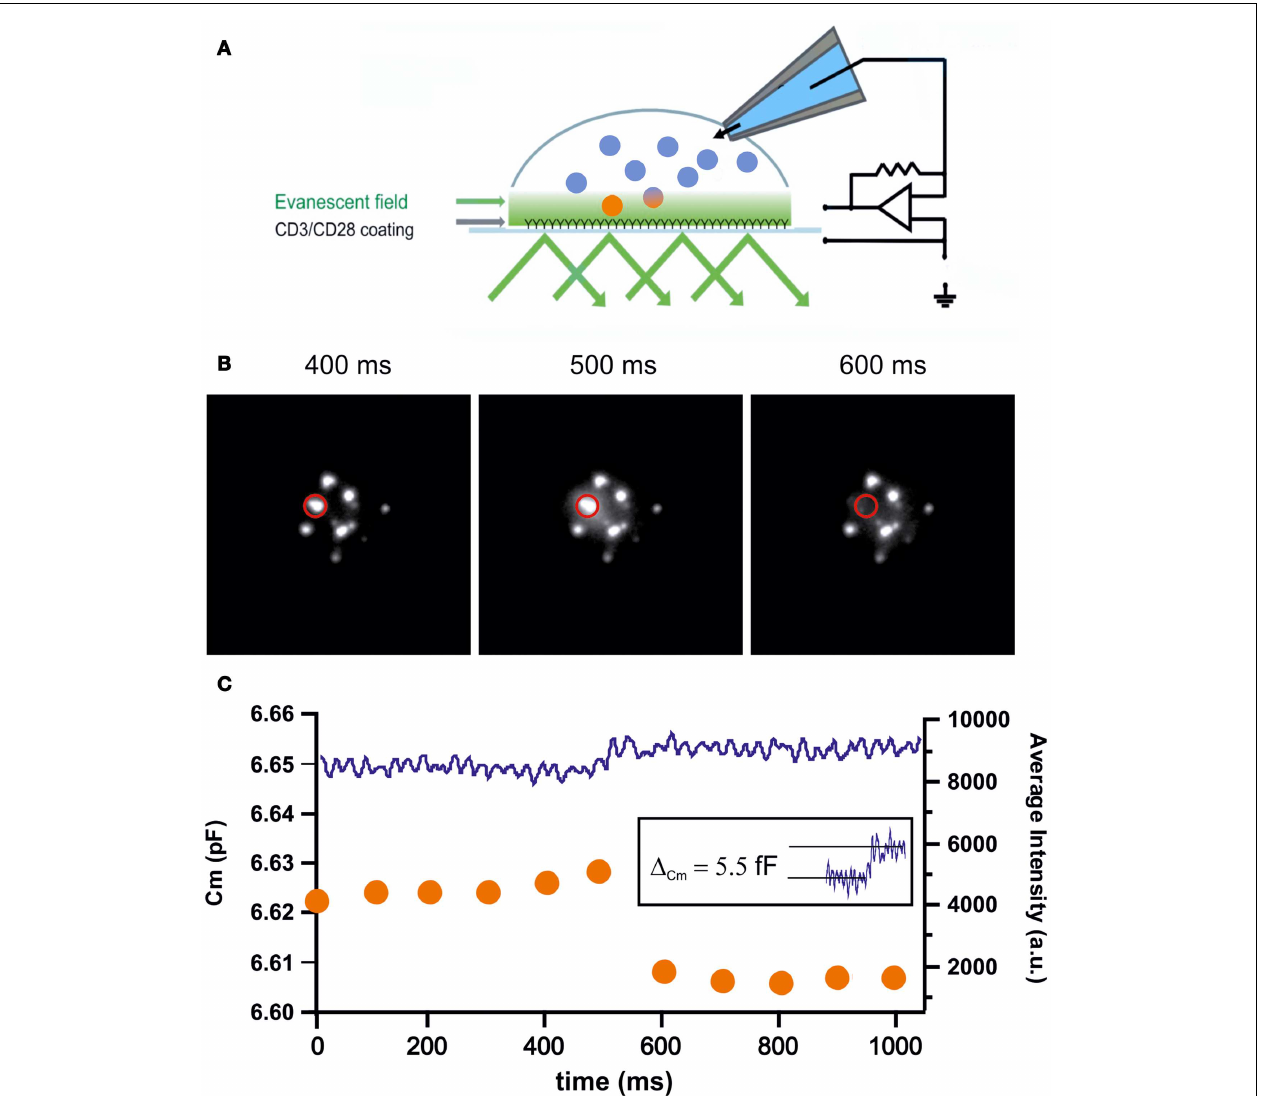
images showing the fusion of an LG within one frame.The middle panel shows the typical “halo” that originates from dequenching and diffusion of the fluorophore. (C) Graph showing the simultaneous measurement of membrane capacitance (left axis) and fluorescence intensity (right axis) of the LG shown in (B) . Upon fusion the fluorescence steeply declines within one frame while in parallel the capacitance increases step-like.The capacitance increase of the fusing vesicle (5.5 fF; inset) corresponds to an LG diameter of 418nm.